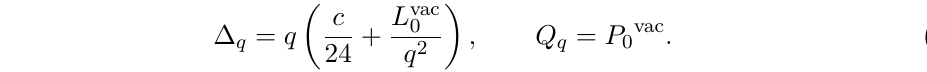
which connects P and ~ P in the warped AdS 3 . P (cid:22) P have been found q